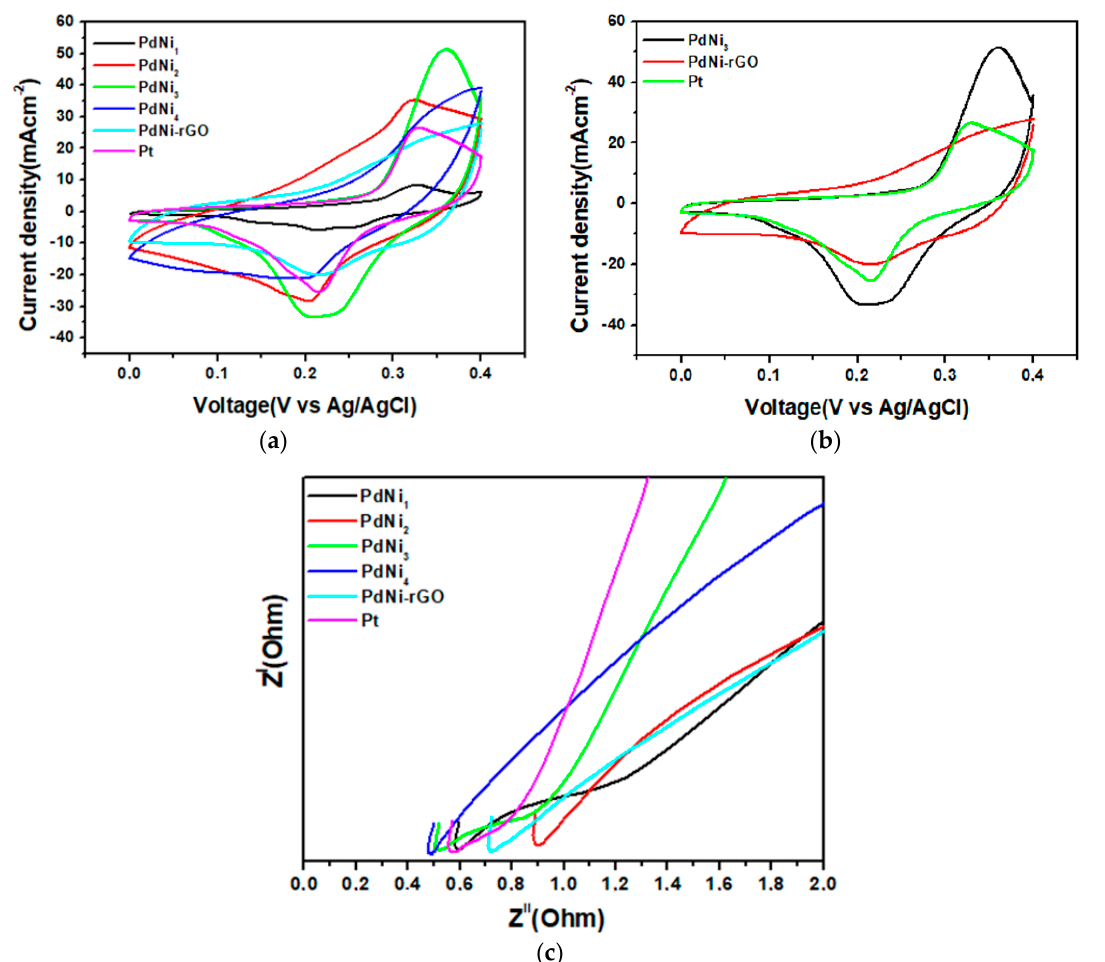
Figure 5. Cyclic voltammetry (CV) analysis curves for ( a ) PdNi x , PdNi-rGO and platinum counter electrodes, ( b ) comparison of CV curves for PdNi x , PdNi-rGO and platinum counter electrodes obtained at a scan rate of 50 mVs − 1 , ( c ) Nyquist plots recorded at 0V potential for PdNi x , PdNi-rGO and platinum. Table 2. Electrochemical parameters for the synthesized counter electrode